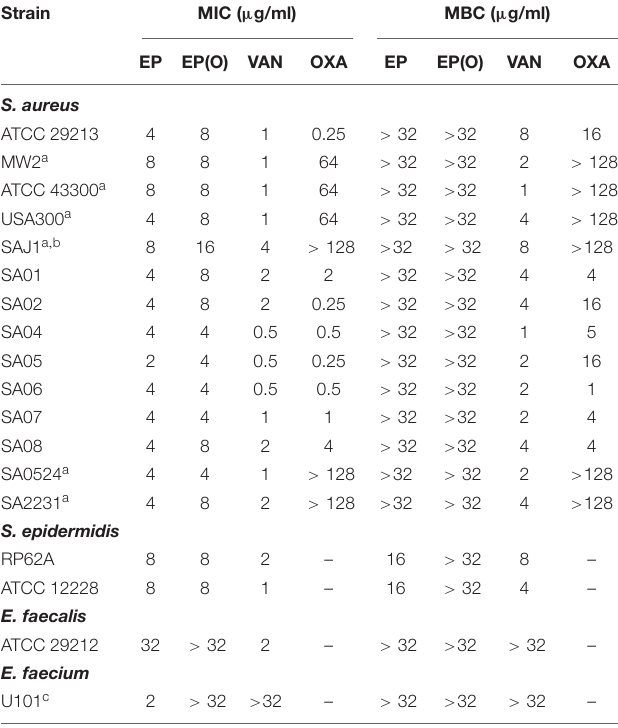
TABLE 1 | Antimicrobial susceptibility test of EP and